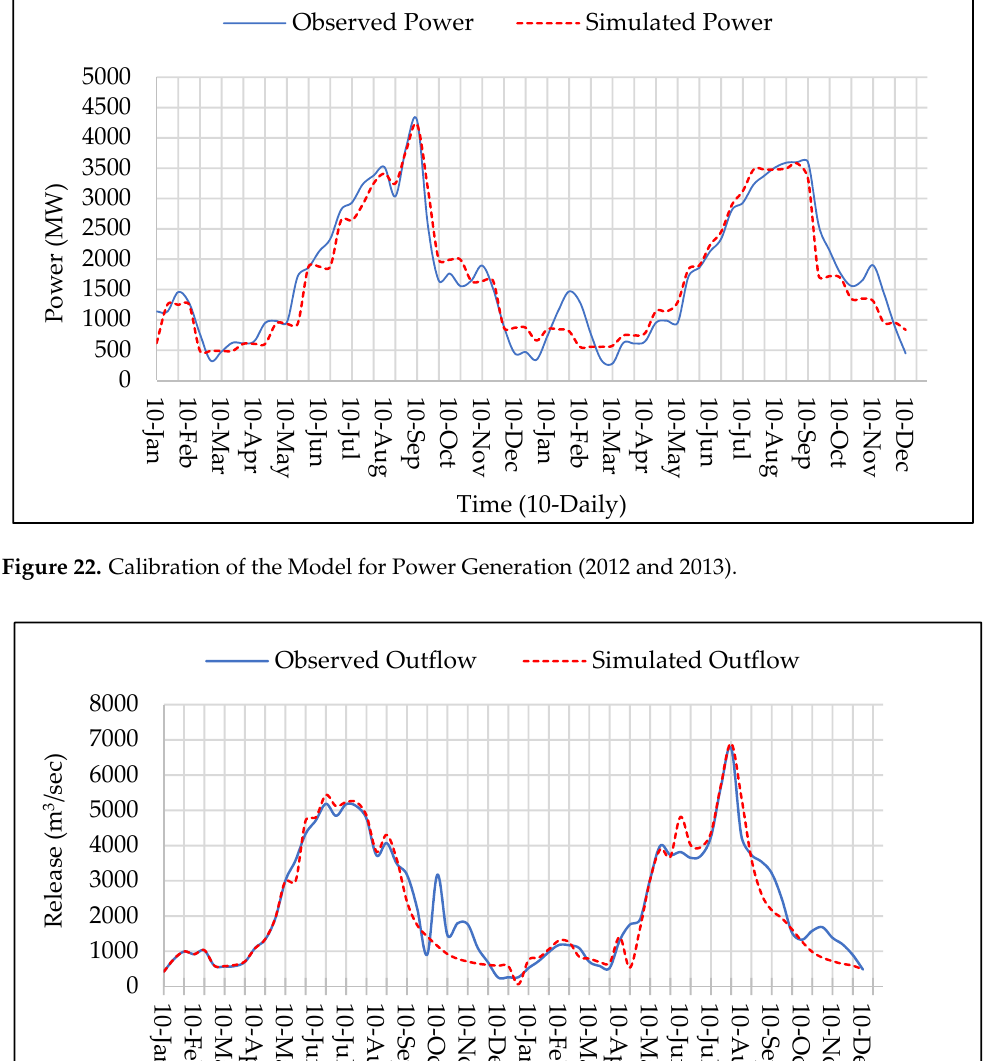
Figure 22. Calibration of the Model for Power Generation (2012 and 2013). The coefficient of efficiency, index of agreement and run-off ratio indicate the satis- factory values for accuracy of the model as shown in Table 6. Table 6. Model efficiency parameters for Model Calibration year 2012 and 2013.